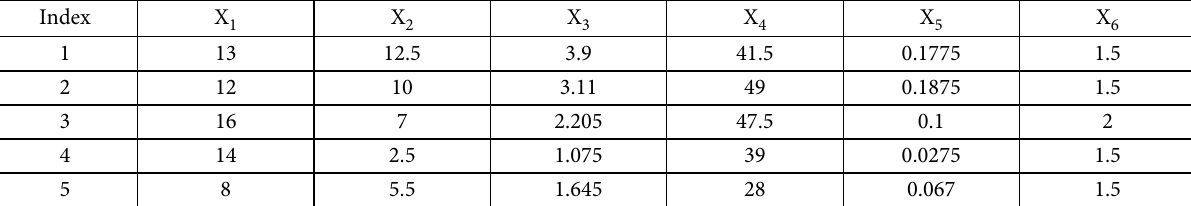
Table 8. Arithmetic mean value of decision-making index of contractor selection for construction works